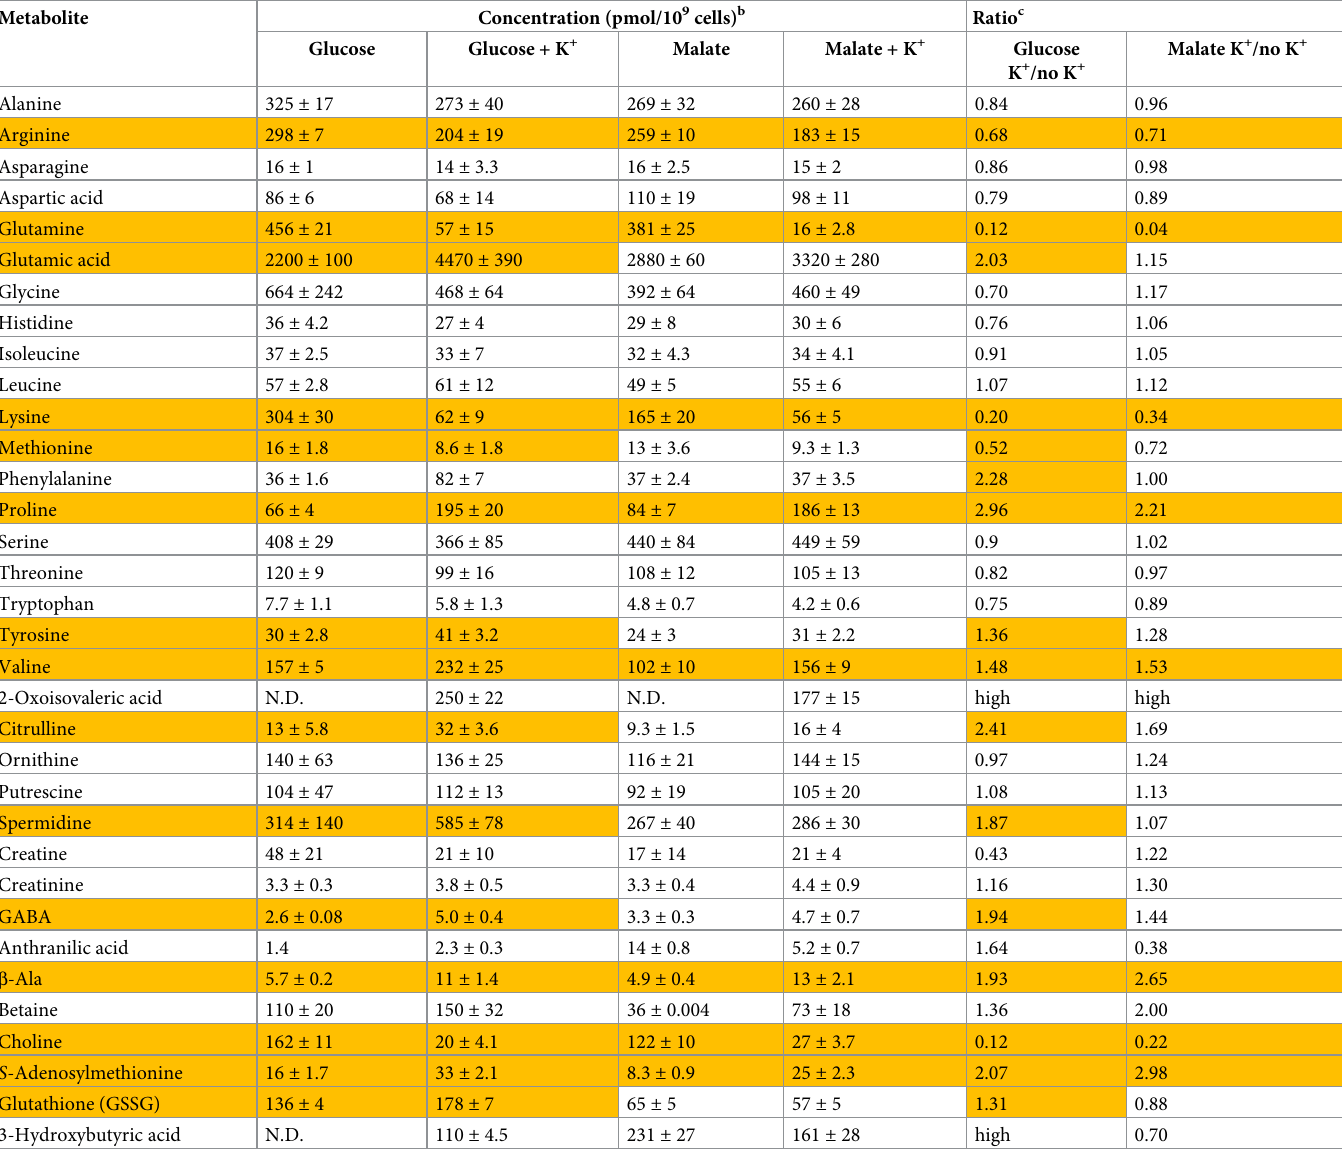
Table 7. Concentration of metabolites involved in amino acid metabolism in wild-type cells in the absence or presence of 10 mM KCl a .